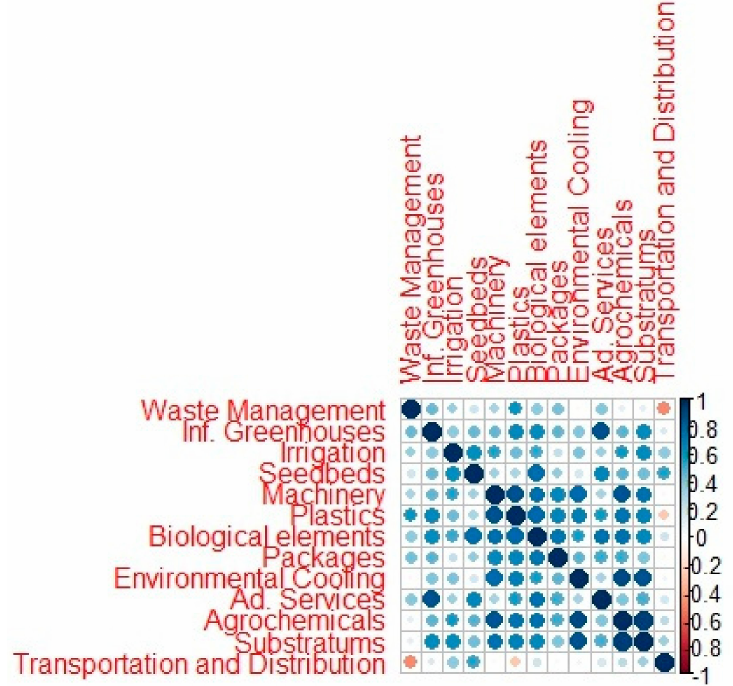
Figure A3. Correlation analysis of improvement of local